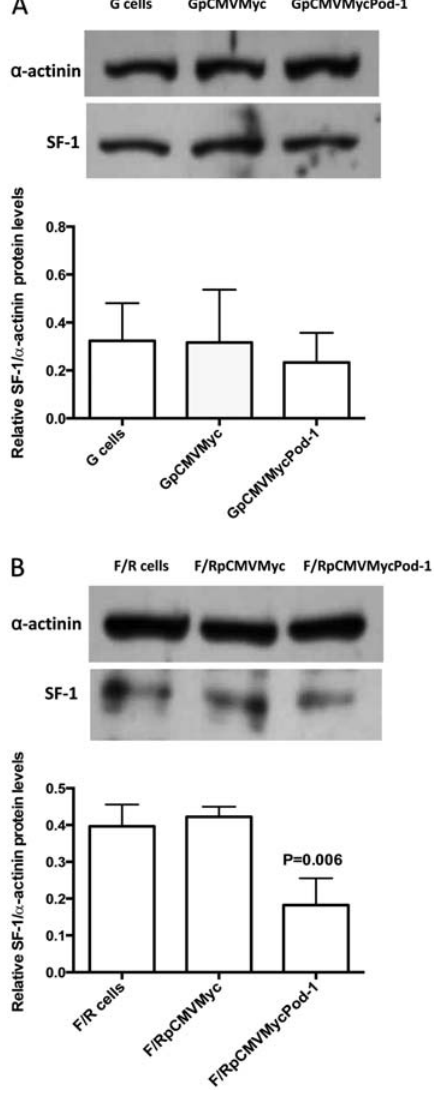
Figure 5. Immunoblotting analysis of relative SF-1/ a -actinin protein levels in primary rat adrenal glomerulosa cells (G cells; A ) and fasciculata/reticularis cells (F/R cells; B ) untransfected or transi- ently transfected with the empty vector pCMVMyc or with pCMVMycPod-1. Protein samples were prepared 72 h post- transfection. Data are reported as the means ± SD from three experiments. Statistical signi fi cance was assessed by paired t -tests between cells transfected with pCMVMycPod-1 or empty vector.